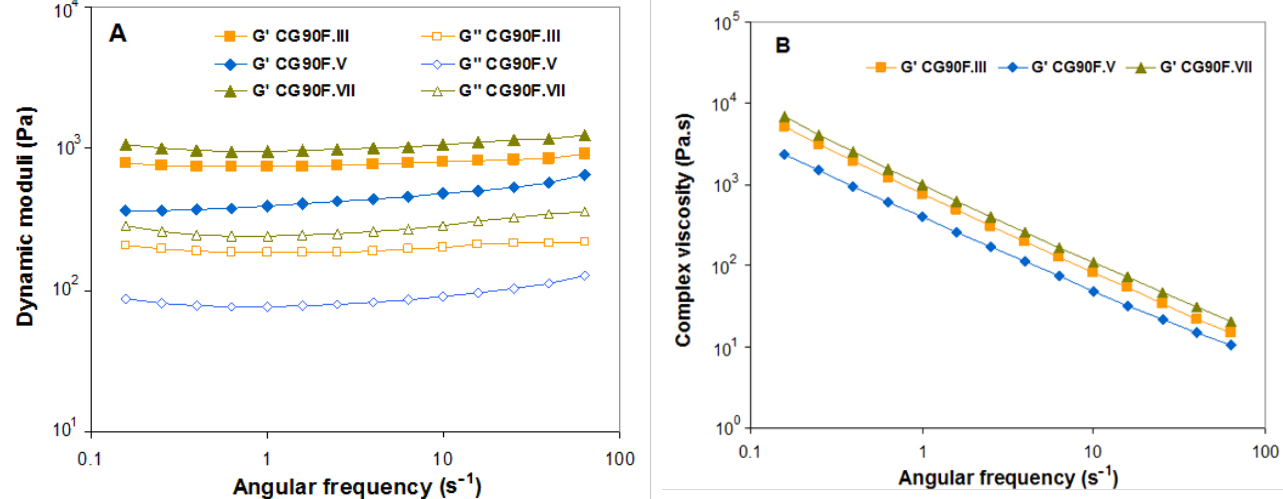
Figure 11. Effect of the cryogenic cycles number (III, V and VII) on the variation of ( A ) storage modulus (G′) ( solid symbols ) and loss modulus (G″) ( open symbols ), ( B ) complex dynamic viscosity (|η*|) function of angular oscillation frequency at 25 °C for XG-based composite hydrogels obtained with a weight ratio between XG and PVA of 9:1, and Feteasca Neagra polyphenolic extracts.